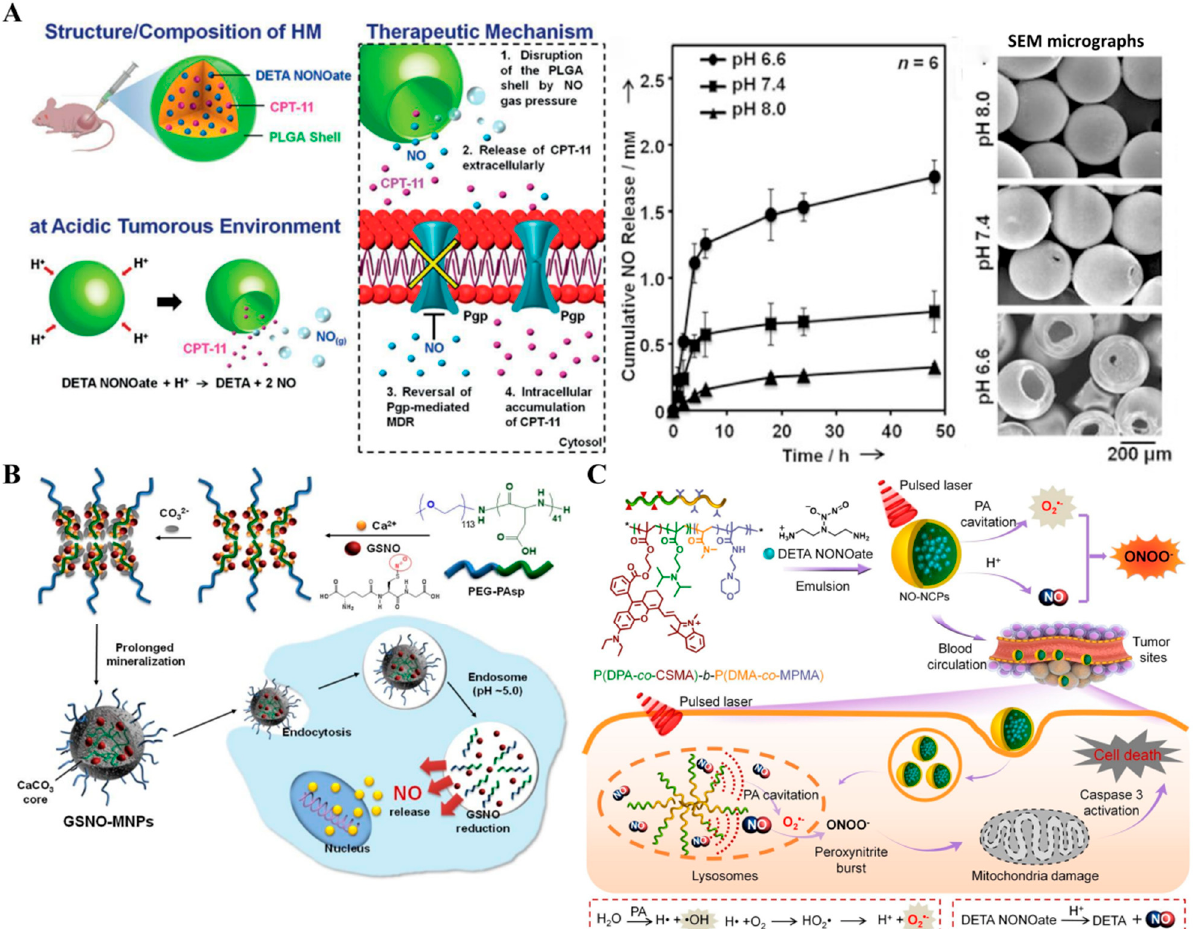
Figure 8. ( A ) Schematic structure/composition of hollow microspheres (HMs) and the mechanism in the treatment of tumors. Reproduced with permission from [49], Angewandte Chemie International Edition, 2015; ( B ) schematic diagram of the preparation of the GSNO–MNPs and the intracellular NO release from the GSNO-loaded CaCO 3 -mineralized nanoparticles (GSNO-MNPs). Reproduced with permission from [102], Colloids and Surfaces B: Biointerfaces, 2016; and ( C ) schematic diagram of the preparation of the NO-based nanosystem. Reproduced with permission from [103], Angewandte Chemie International Edition, 2021.